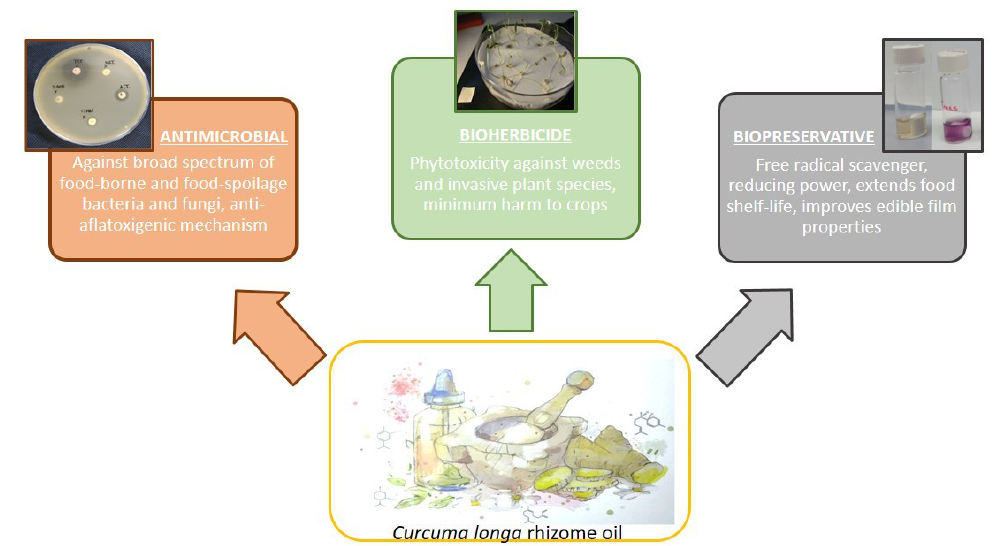
Figure 2. Representation of the roles that Curcuma longa rhizome oil can play in the safer and more sustainable emerging agri-food industry: antimicrobial, herbicidal and antioxidant activities.